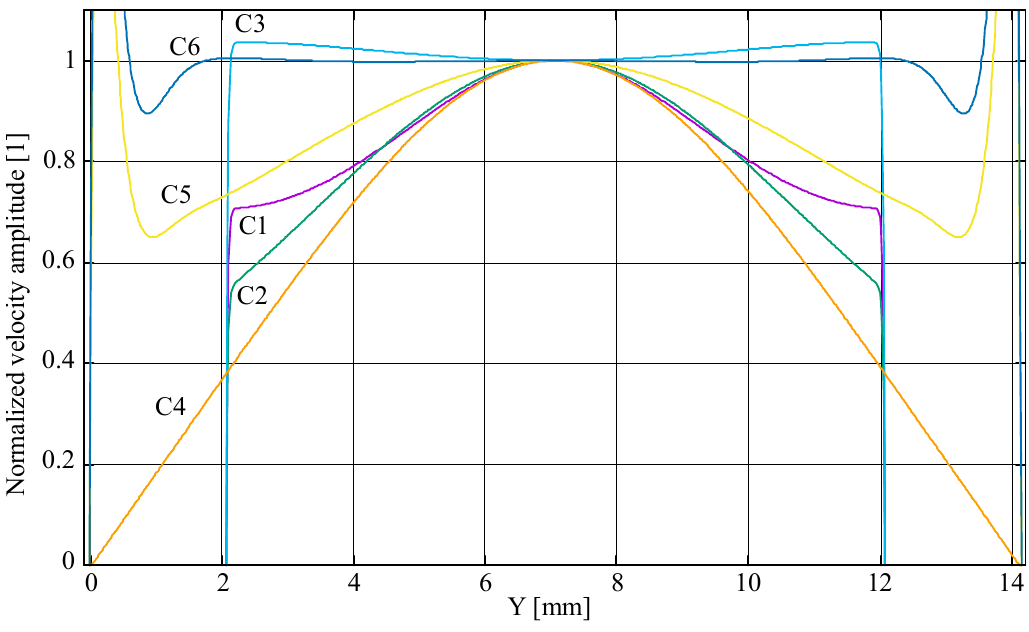
Figure 4. Numerical simulation of the mean velocity of fluid in the microfluidic interfaces of Figure 2 (mm/s) (the scale has been limited to v < 1 mm/s to better show the velocity inside the chamber). A complementary way to look at the velocity uniformity in the chamber is to compare the fluid velocity in a section in the middle of the chamber, as shown in Figure 5.